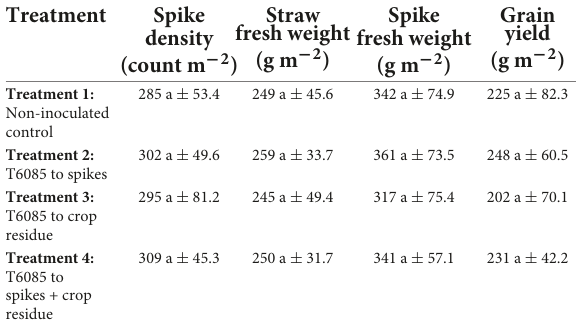
TABLE 2 Effect of treatments on some agronomic traits of